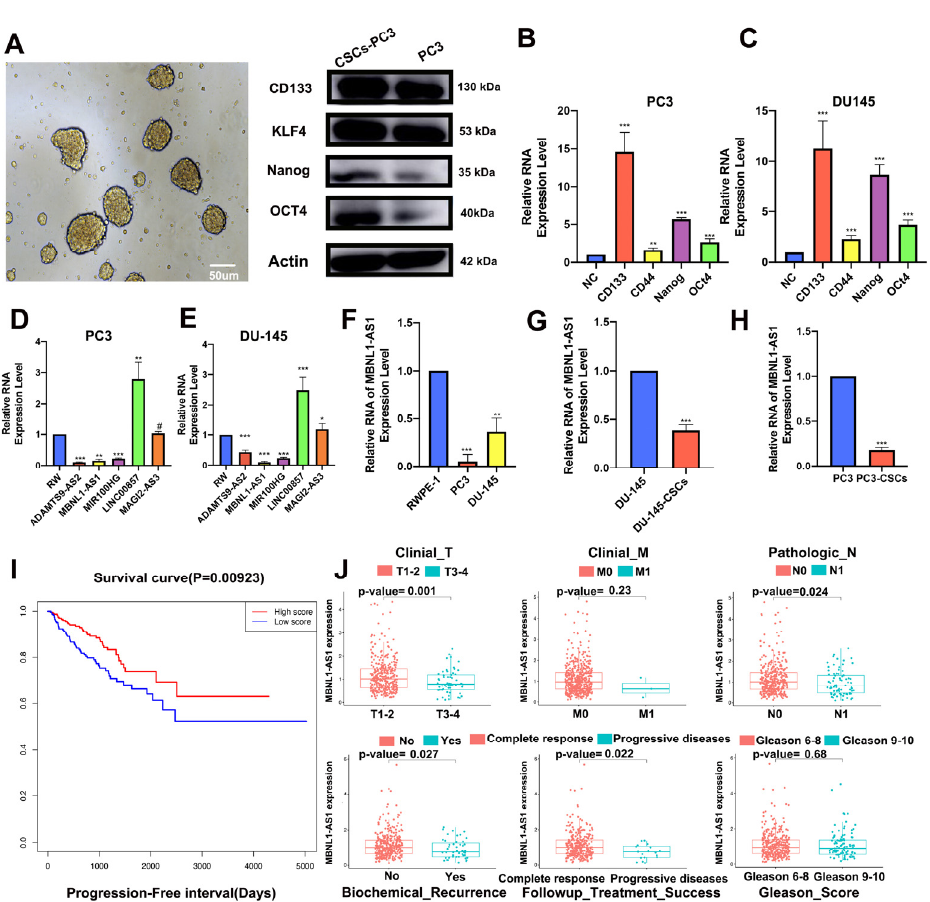
Figure 2. Identification of mRNAsi-related lncRNAs. PC3-CSCs were isolated and cultured under serum-free conditions. ( A ) Sphere formation, characteristic of CSCs, was visualized by microscopy. ( B , C ) Changes in protein ( B ) and mRNA ( C ) expression levels of stemness markers CD133, KLF4, NANOG and OCT4 were examined by western blot and RT-qPCR analyses, respectively. ( D – F ) mRNA expression of five candidate genes in normal PC epithelial cells and tumor cells was examined by qPCR. ( G , H ) mRNA expression of MBNL1-AS1 in PCSCs was examined by qPCR. ( I ) Survival analysis demonstrating the prognostic value of MBNL1-AS1 in the TGCA-PRAD dataset. ( J ) Correlation analysis showing the correlation between MBNL1-AS1 expression and clinical characteristics. * p -value < 0.05; ** p -value < 0.01; *** p -value < 0.001; # p > 0.05, respectively.